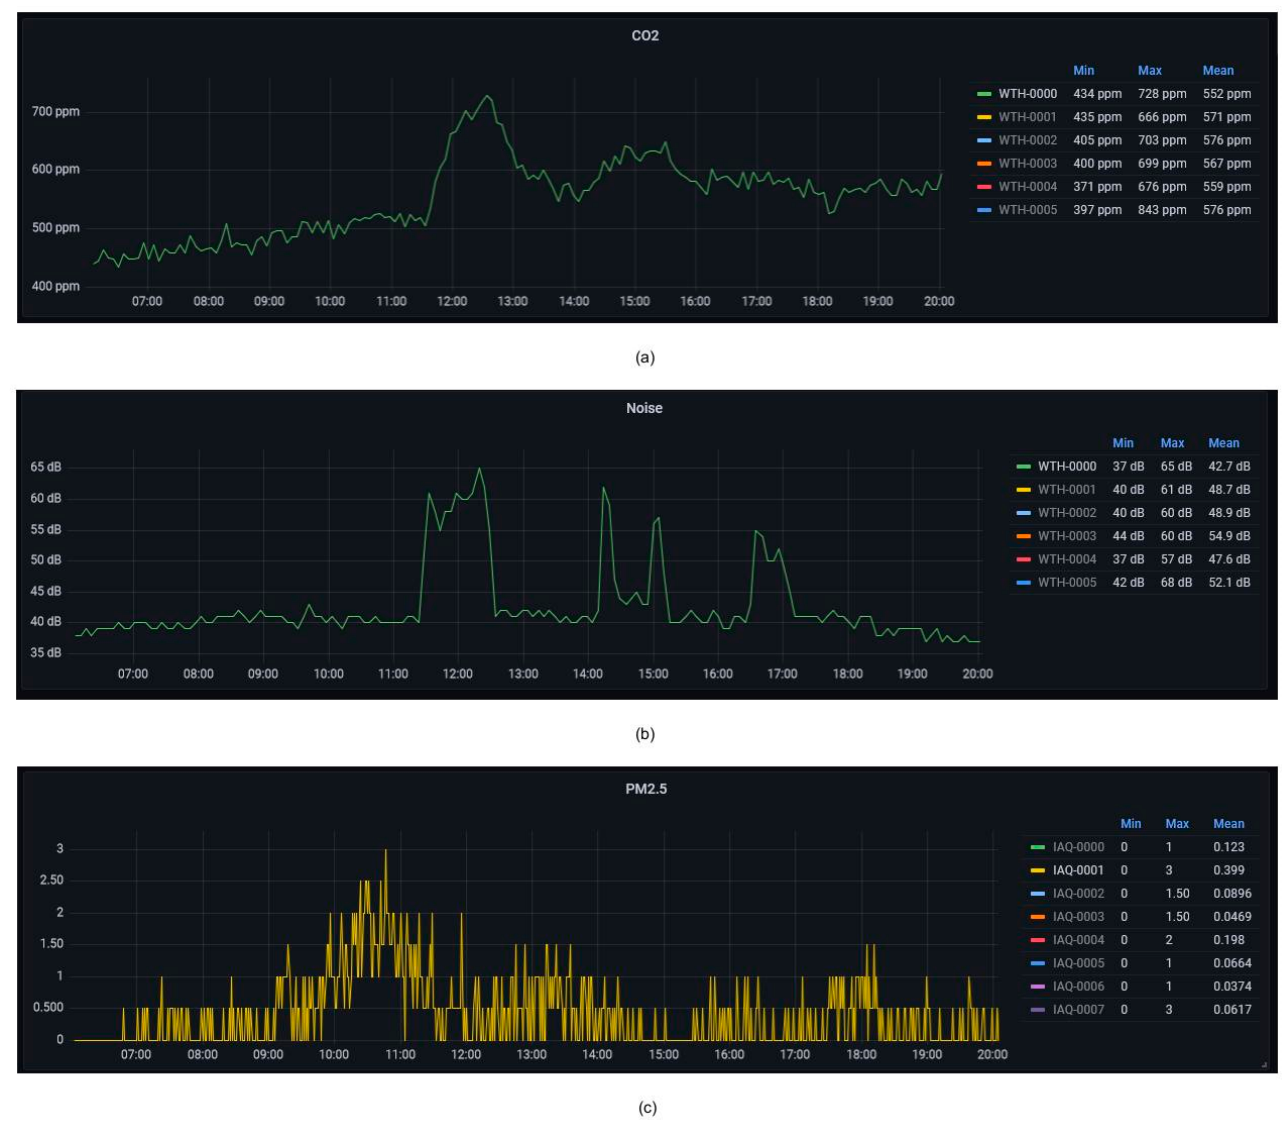
Figure 10. Time series from sensors in the large meeting room: ( a ) Weather station shows an increase in CO 2 as occupant levels increase. ( b ) Weather station shows noise levels increase as occupant levels increase. ( c ) Indoor air quality sensor shows PM 2.5 levels.